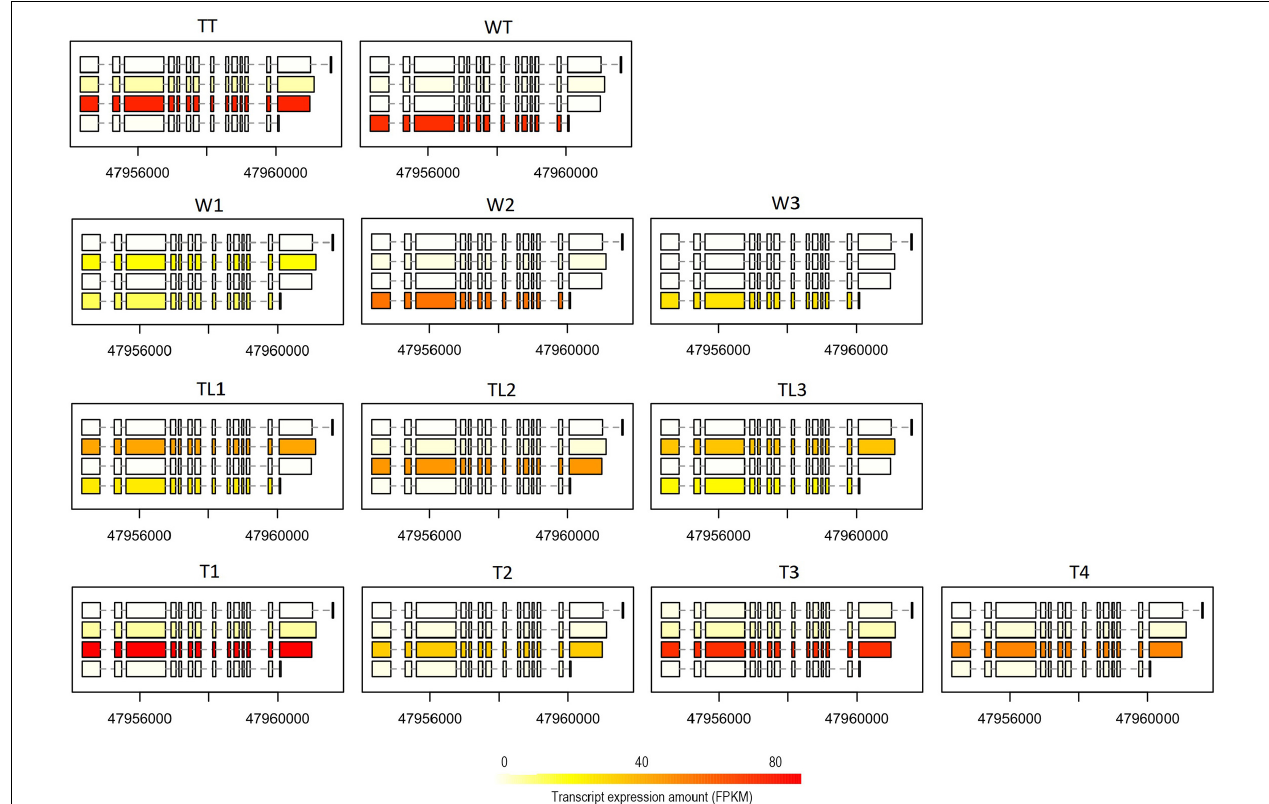
FIGURE 5 | Expression of ARF6 at the transcript level in the 12 transcriptomes. For each transcriptome, the expression quantities of the four different transcript forms have been indicated by the color depth of the rectangles (exons) connected by dashed lines (introns) in the